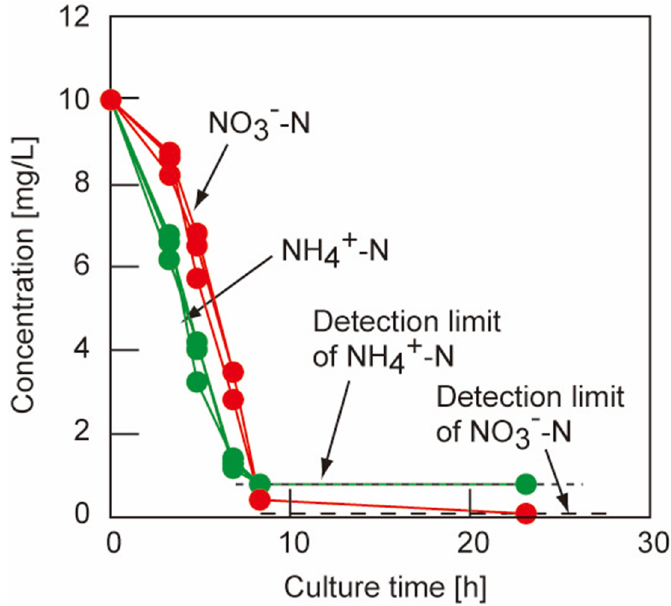
Figure 3. Comparison of nitrogen removal between denitrification of nitrate nitrogen and nitrification of ammonia nitrogen by alginate beads: red circle, nitrate-nitrogen concentration, green circle, ammonia-nitrogen concentration. The alginate beads were prepared by adding 1 mL of R. gra suspension to 10 mL of 1.5% concentration sodium alginate solution. The detection limit of nitrate nitrogen by the ion chromatography method is 0.2 mg/L, and that of ammonia nitrogen by the indophenol blue method is 0.8 mg/L.